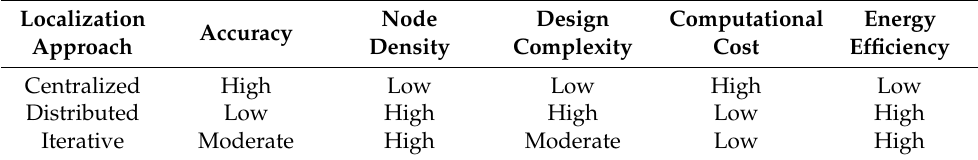
Table 1. Performance Comparison of Localization